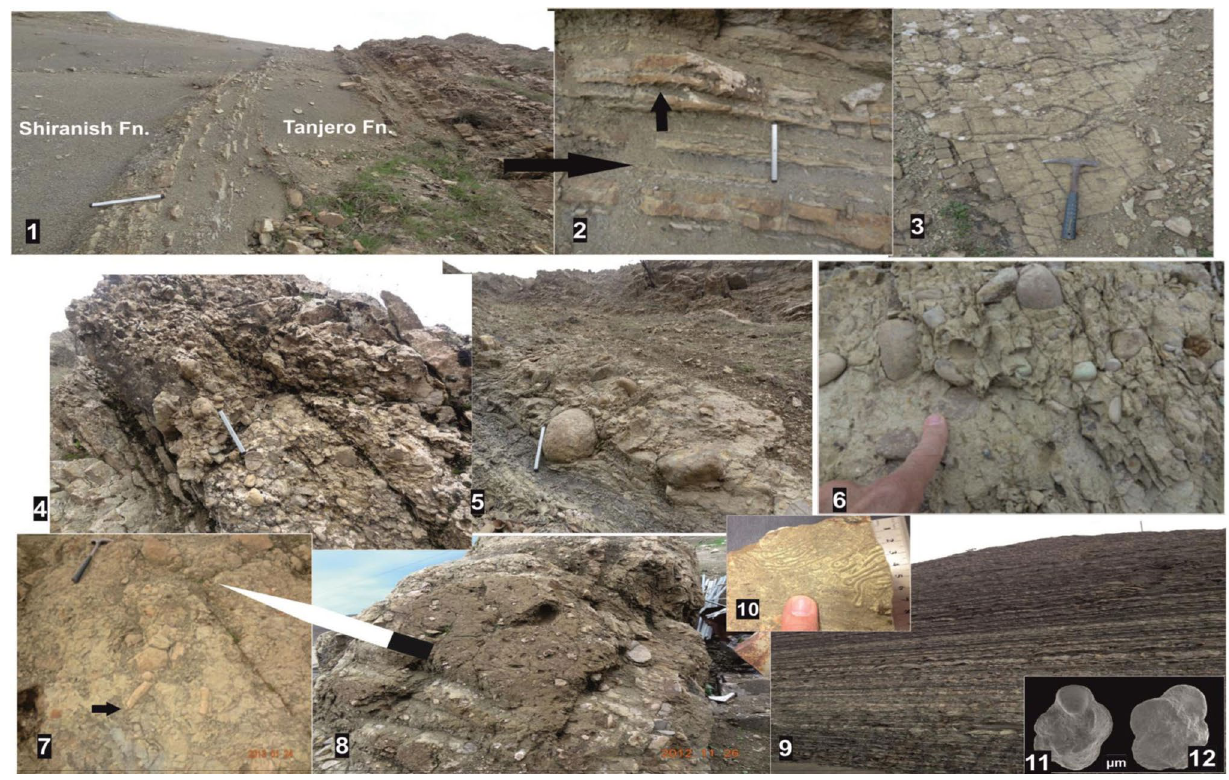
Fig. 4 1. Shiranish/Tanjero fns. conformable boundary. 2. Sole marks at the base of the first bed of sandstone. 3. Giant Planolites trace fos- sils at the top of sandstone (LST, second third order). 4 and 5. Con- glomeratic facies associations at the lower part of Tanjero fn. 6. Gravel and chert boulders within planktonic mudstone of Tanjero for-